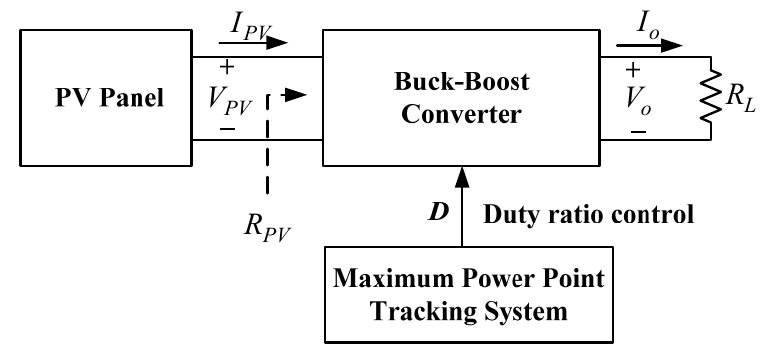
Figure 9. PV system with buck-boost converter incorporated.